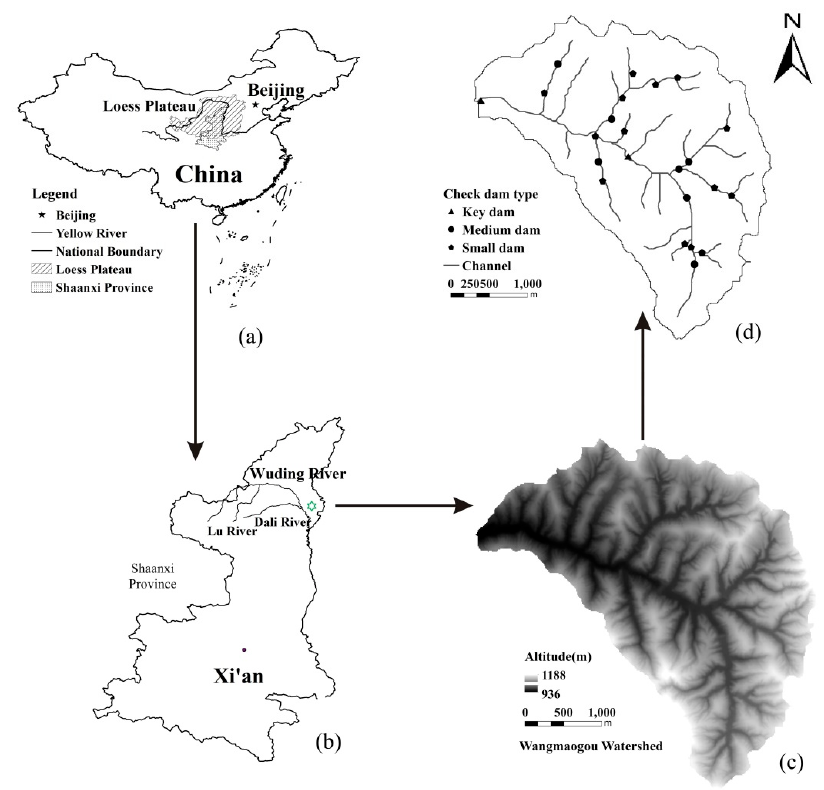
Figure 1. Location of the study area ( a , b ); the Wangmaogou watershed ( c ); and the layout of check dam types ( d ).